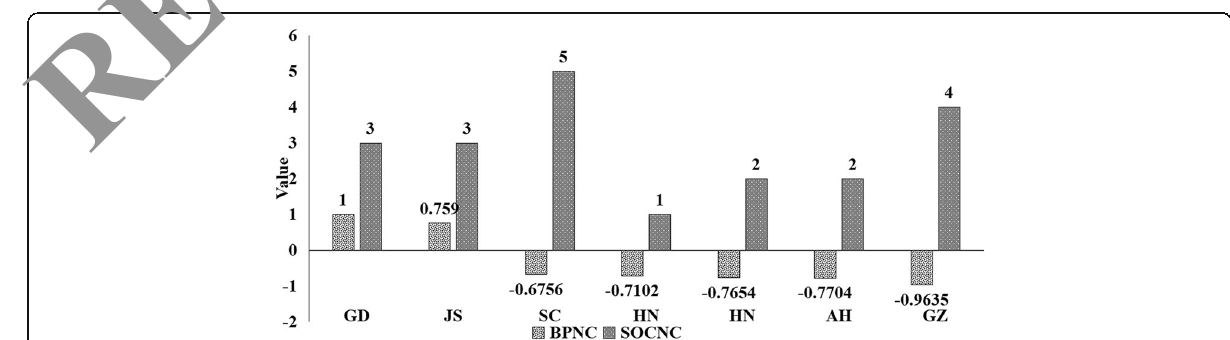
Fig. 5 Comprehensive analysis of performance of industrial cluster management in small- and medium-sized